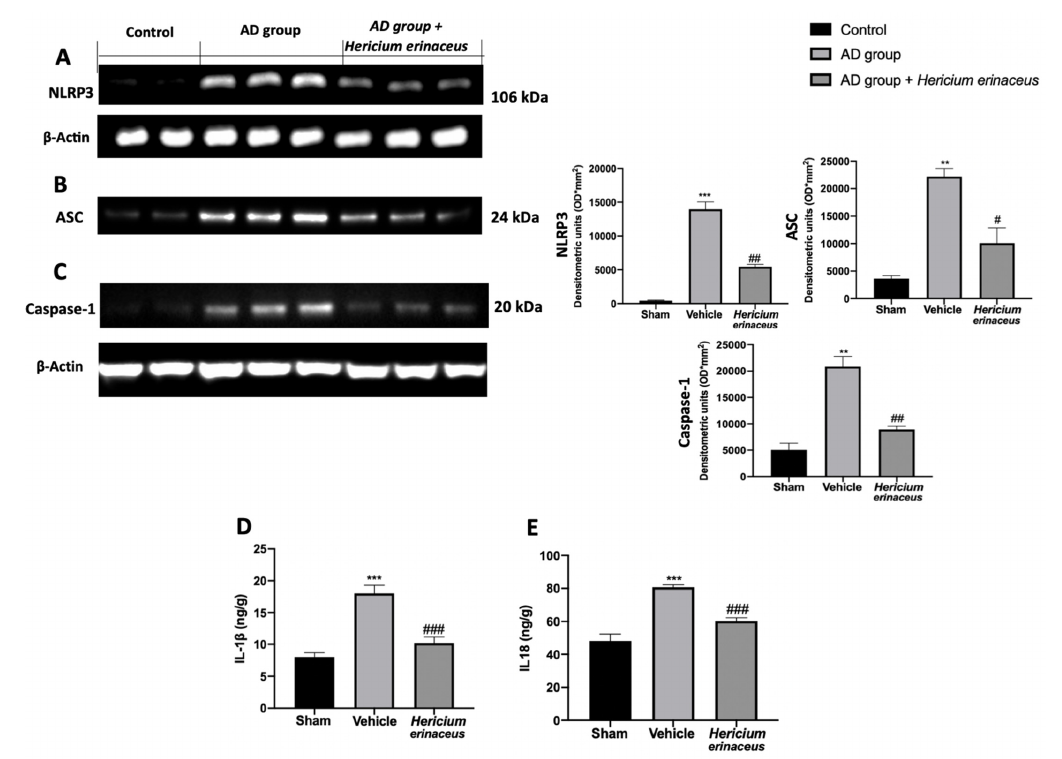
Figure 4. Hericium erinaceus administration downregulated the NLRP3 inflammasome activation in hippocampus: Western blot analyses of NLRP3 ( A ), ASC ( B ), and Caspase-1 ( C ) expression; IL1 β ( D ) and IL18 ( E ) levels. For western blot and ELISA analyses, n = 5 animals from each group and for each analysis were employed. A p -value of less than 0.05 was considered significant. # p < 0.05 vs. vehicle, ** p < 0.01 vs. control, ## p < 0.01 vs. vehicle, *** p < 0.001 vs. control, ### p < 0.001 vs. vehicle.